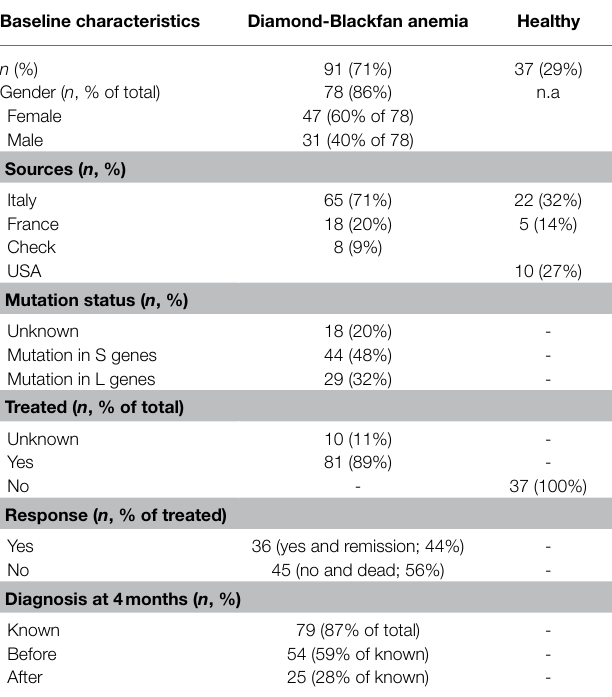
TABLE 1 | Demographic and clinical data of the Diamond Blackfan anemia (DBA) patients and healthy controls included in the study. Baseline